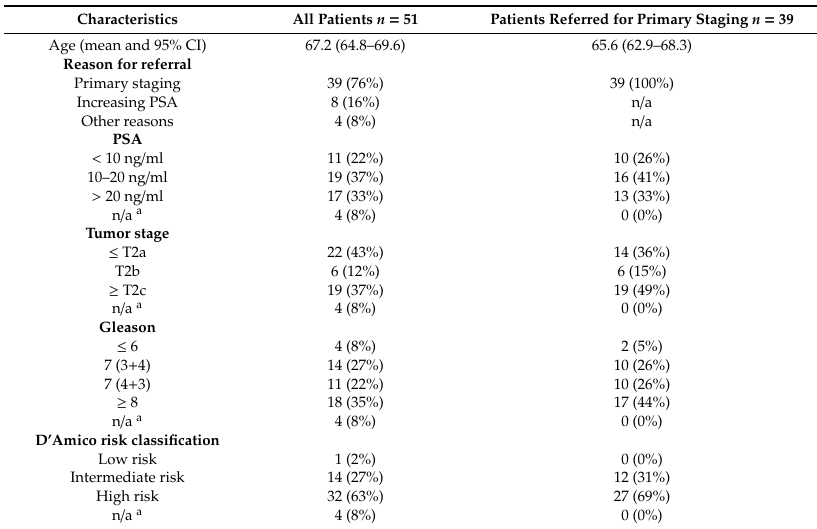
Table 1. Patient